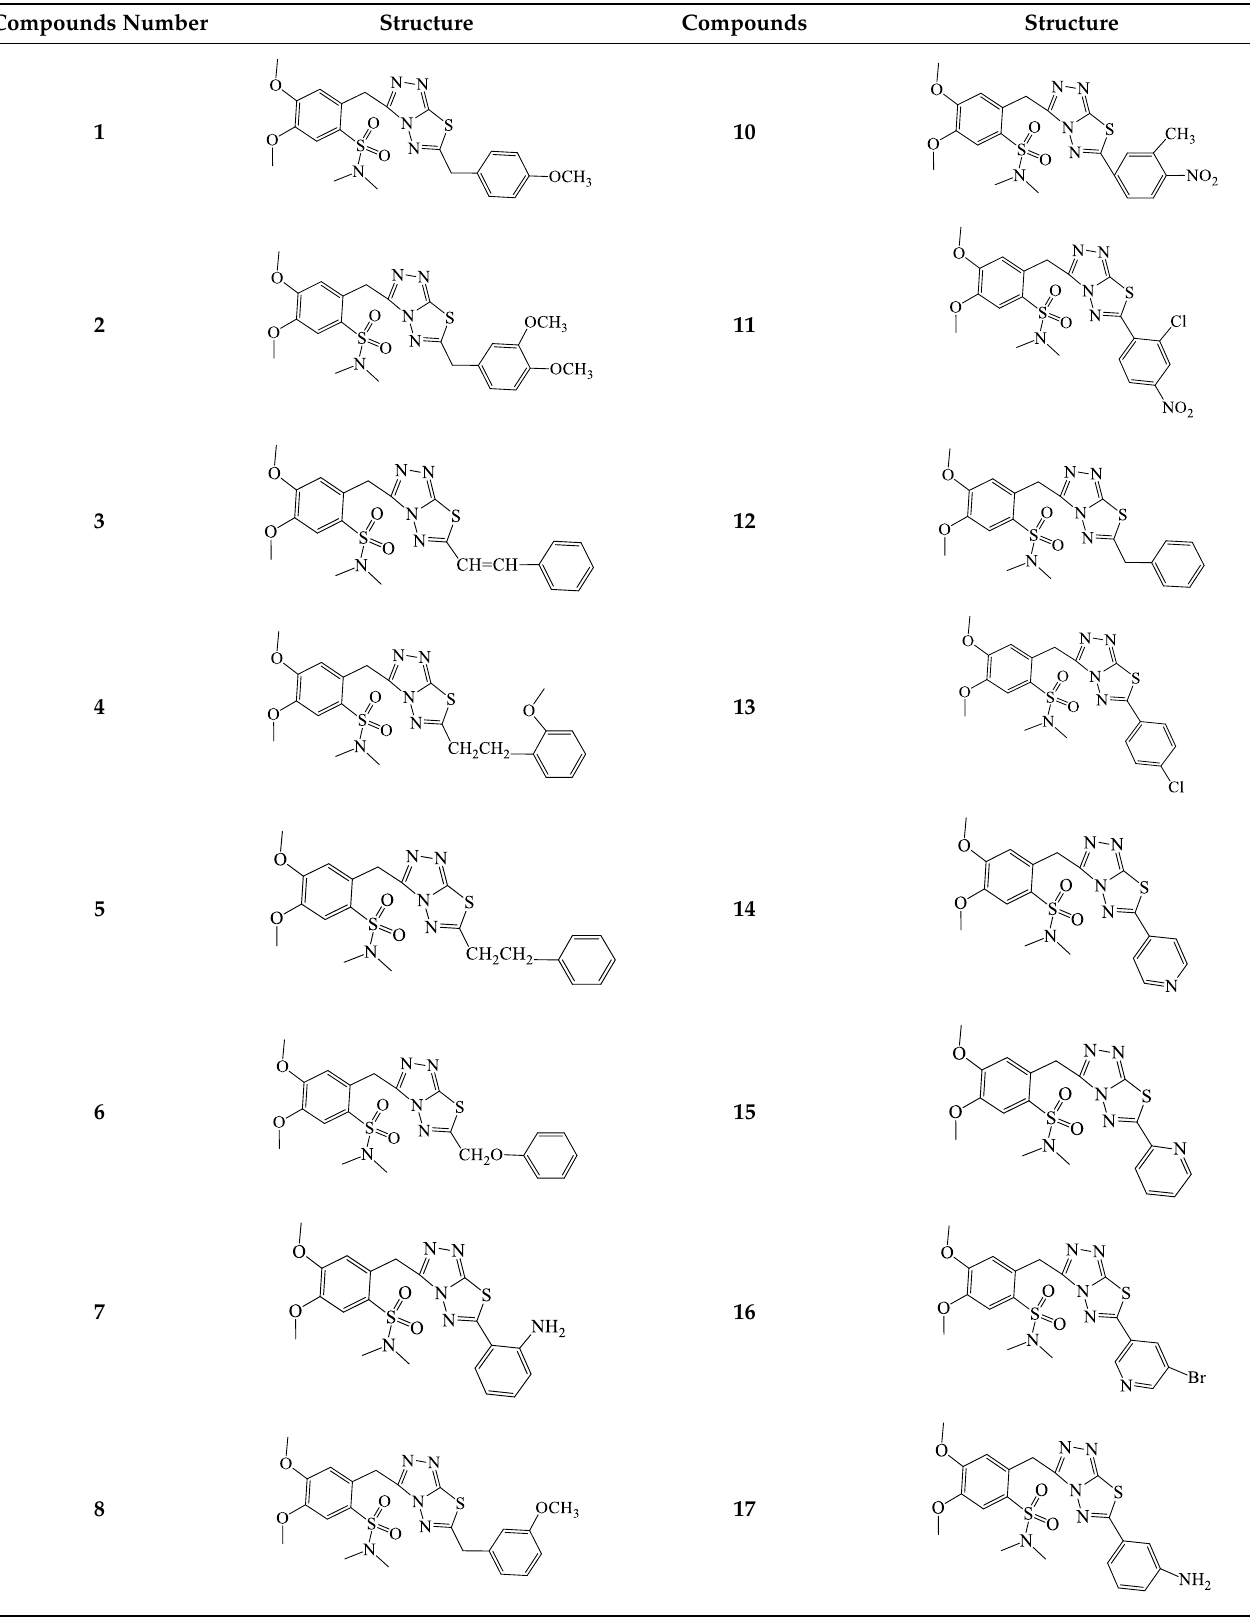
Table 1. Structure of tested compounds.